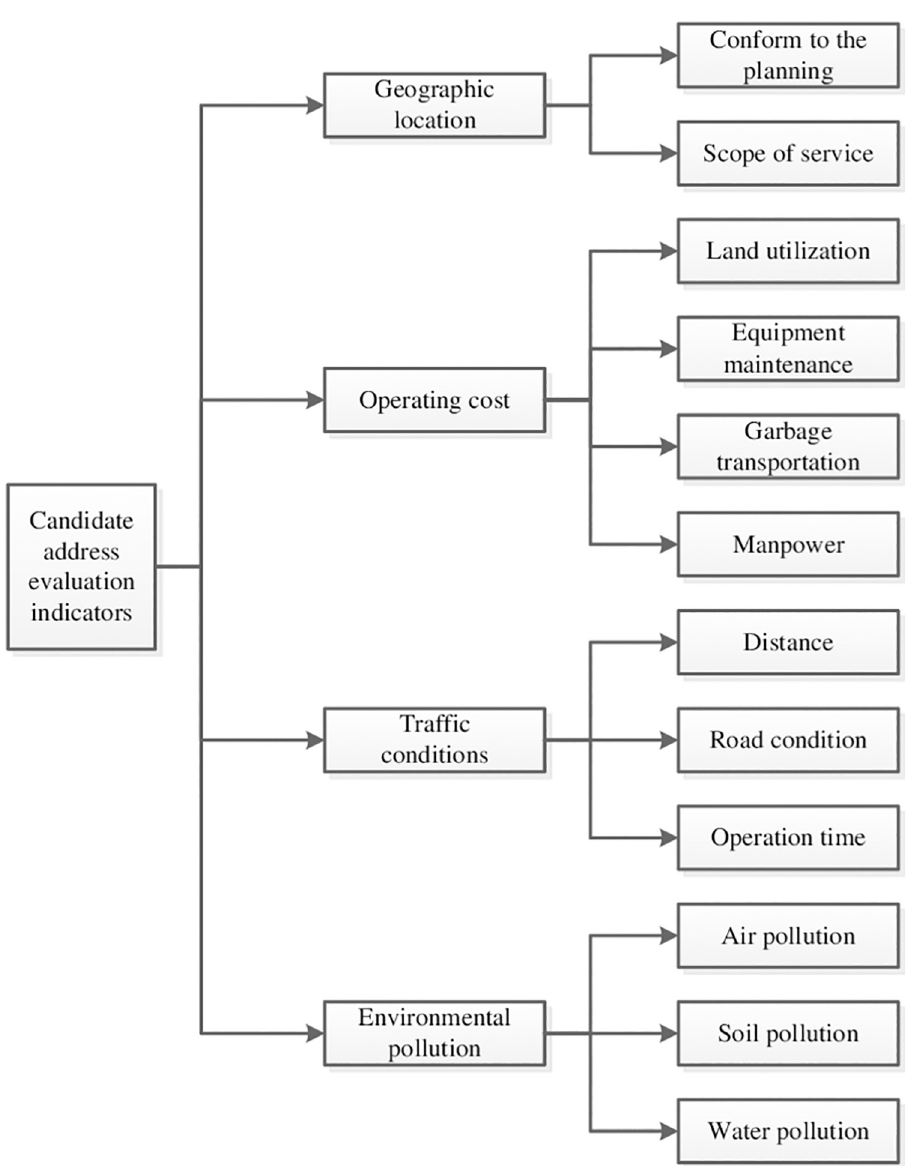
Fig 1. The evaluation index system of candidate